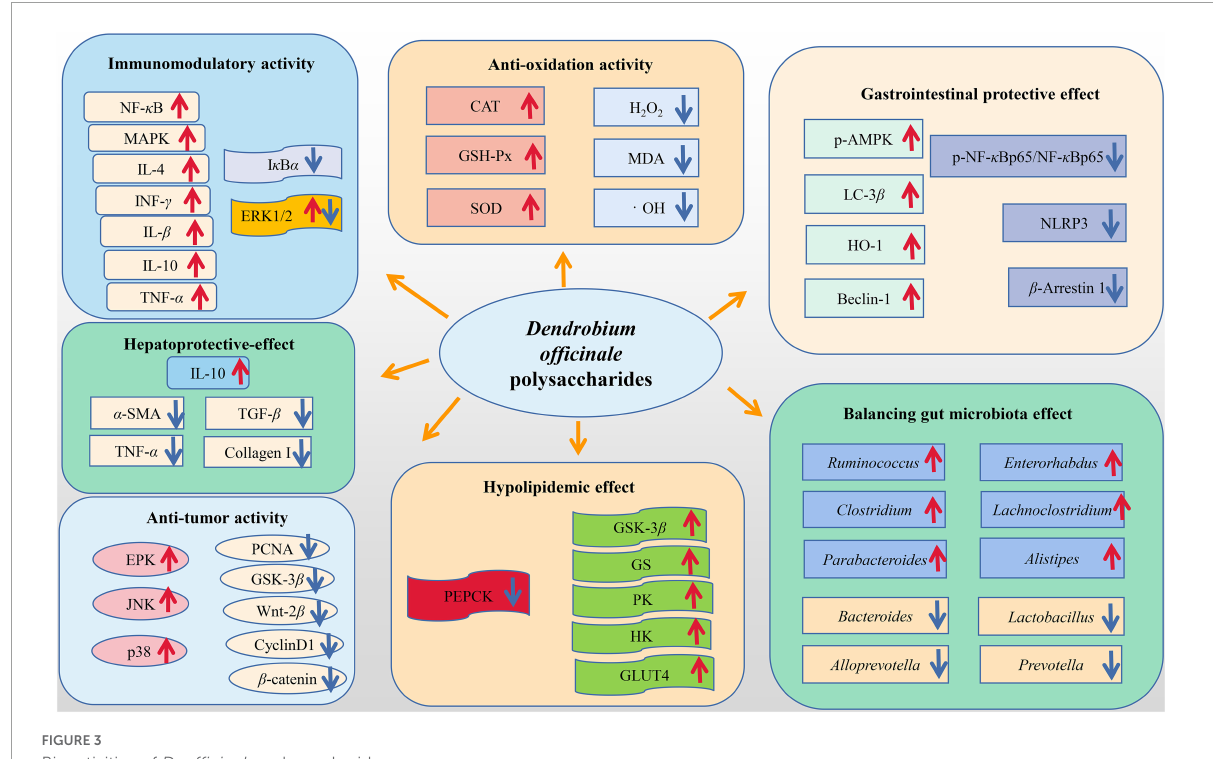
FIGURE3 Bioactivities of D. officinale